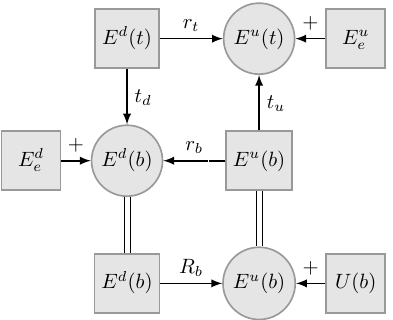
Figure 3. Flux interaction diagram for the emitted radiation in a system of a vegetation layer on top of a reflecting surface (e.g., soil). U indicates the upward emitted fluxes at a surface. E u e and E d e are the upward and downward emission of the vegetation